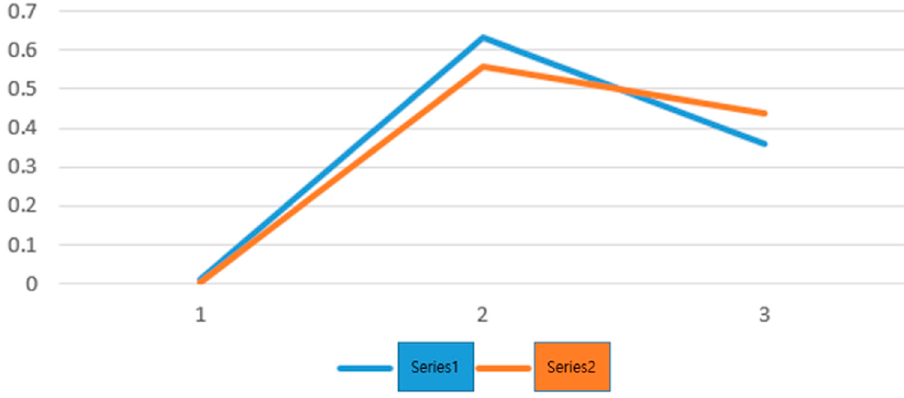
Figure 19. Comparison between the appearance frequency of “tropical night” and maximum power. (“Living Culture” section of Naver news, 2017).